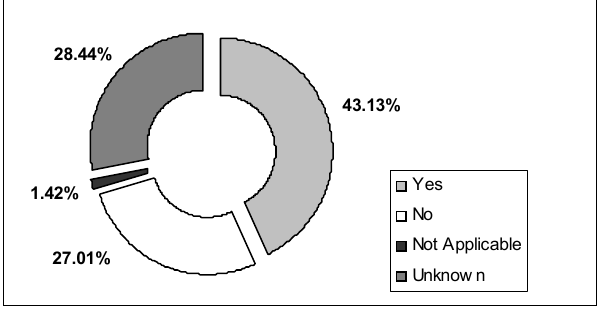
Figure 1: Offline brand name existence